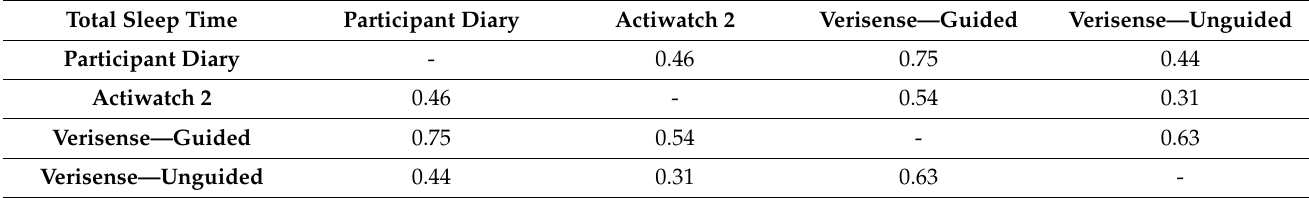
Table 5. TST correlations.